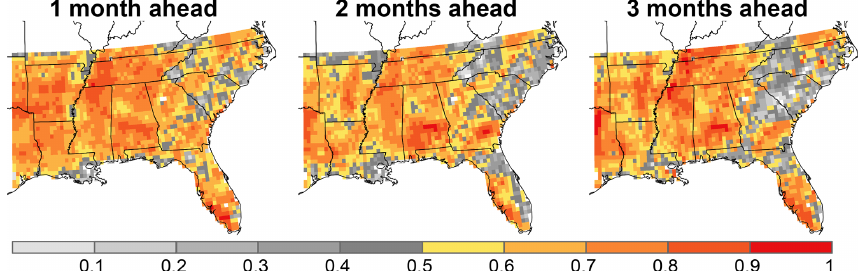
Figure 3. Correlation coefficient between 1- to 3-month-ahead soil moisture forecasts with the SMAP soil moisture observations; grid cells with insignificant correlations (based on 18 monthly data points) are grayed